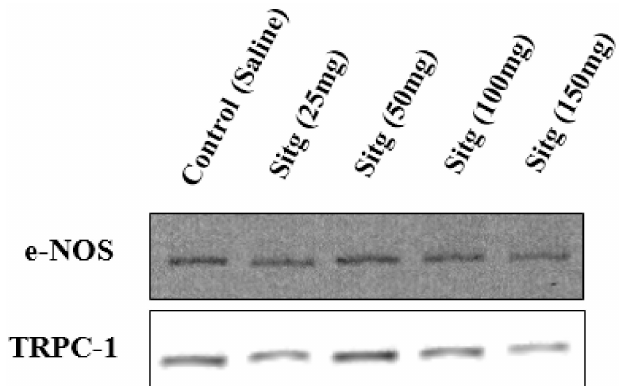
Figure 15. Expression of e-NOS and TRPC-1 proteins in ischemic heart tissues treated with different doses of sitagliptin (Sitg (25, 50, 100, & 150 mg)), compared to the control (Saline) group. The blots show that both proteins are significantly expressed in sitagliptin (50 mg) treated